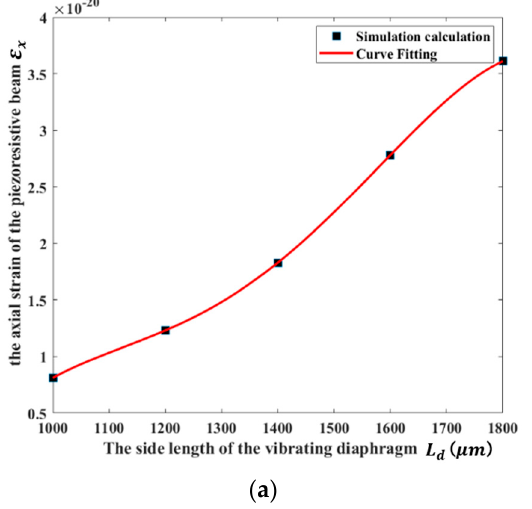
Figure 6. The simulation results between the axial strain of the piezoresistive beam ε x and the parameters of the sensor structure: ( a ) the side length L d of the vibrating diaphragm; ( b ) the length L of the piezoresistive beam.